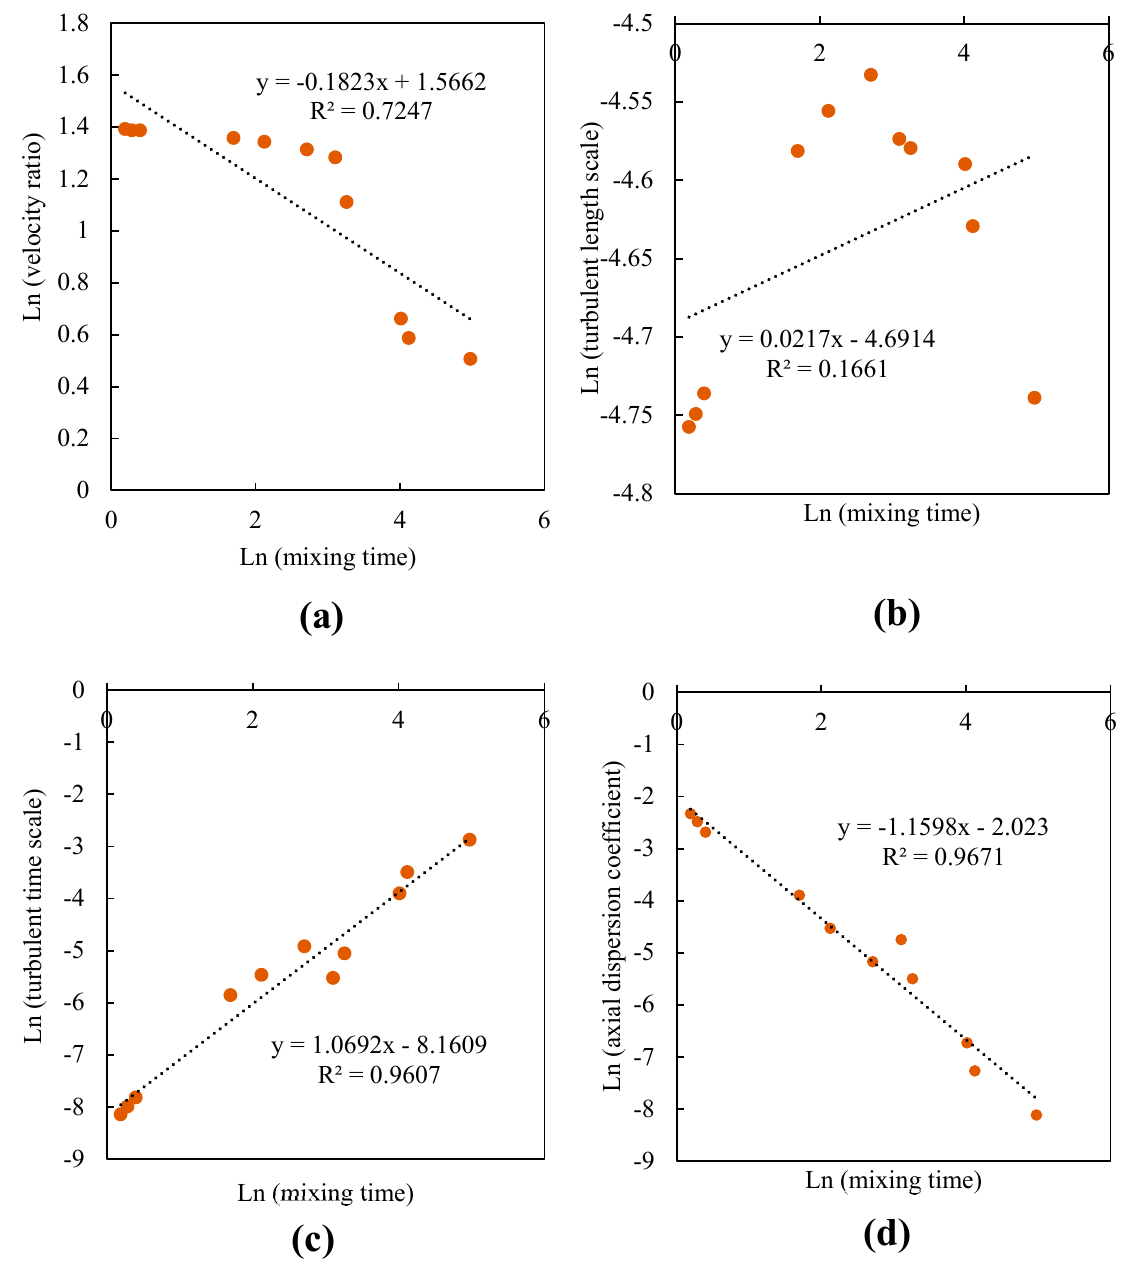
Figure 12. Natural logarithm of (a) velocity ratio, (b) turbulent length scale, (c) turbulent time scale, (d) axial dispersion coefficient vs. natural logarithm of mixing time.